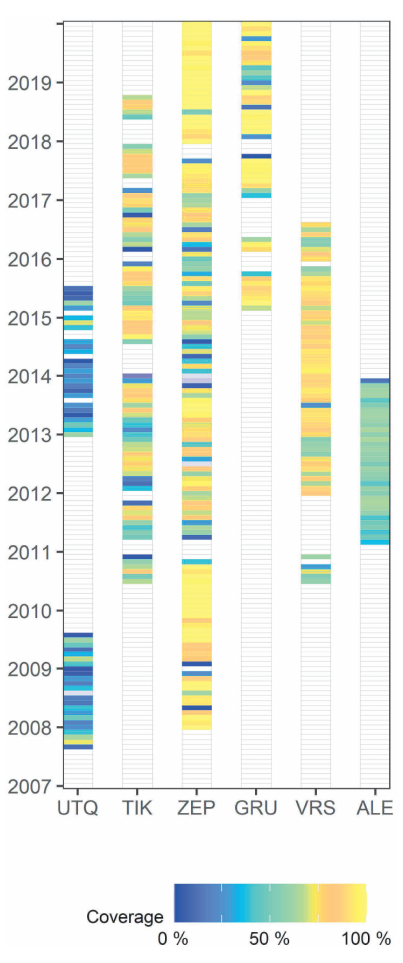
Figure 1. Data coverage for each of the sites. Each individual cell corresponds to 1 full month of measurements. The fill colour cor- responds to the total amount of available hourly data as a percent- age of the total hours within that month. The abbreviations along the bottom axis correspond to Utqia˙gvik, Tiksi, Zeppelin Mountain, Gruvebadet, Villum research station, and